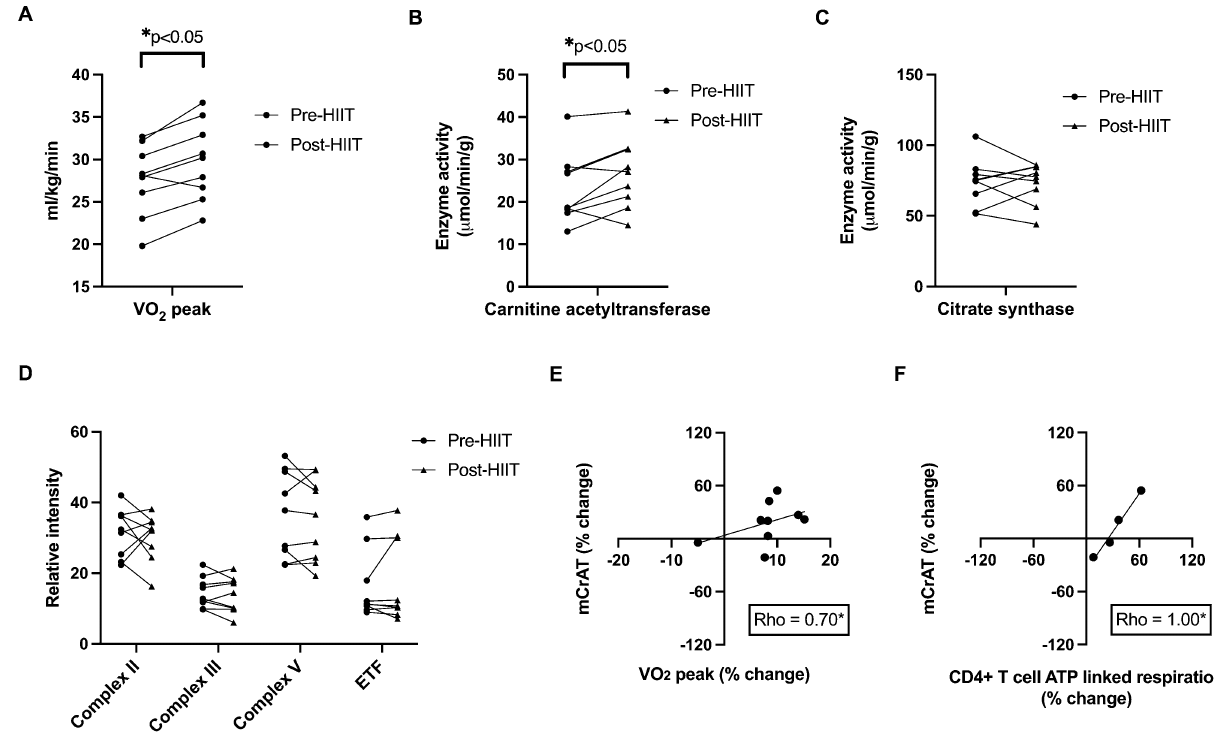
Figure 3. HIIT increases RA skeletal muscle carnitine acetyltransferase enzyme activity in association with increased cardiorespiratory fitness and changes in CD4 + T cell oxidative function. Graphs show individual rheumatoid arthritis (RA) participant (subgroup n = 9) ( A ) cardiorespiratory fitness (relative VO 2 ; ml/kg/min), skeletal muscle ( B ) carnitine acetyltransferase (mCrAT) and ( C ) citrate synthase enzyme activity (μmol/min/g) before (Pre-HIIT) and after (Post-HIIT) high-intensity interval training (HIIT). ( D ) Graphs show individual RA participant protein expression of mitochondrial complexes II, III, and V and electron transfer flavoprotein (ETF) Pre-HIIT and Post-HIIT. ( E ) Scatter plot depicts relationship between percent change in RA mCrAT enzyme activity (y-axis) and percent change in relative peak VO 2 (ml/kg/min) (x-axis) following HIIT. ( F ) Scatter plot depicts relationship between percent change in RA mCrAT enzyme acitivity (y-axis) and percent change in peripheral CD4 + T cell ATP linked respiration (y-axis) following HIIT. * p < 0.05 for paired t-tests and Spearman